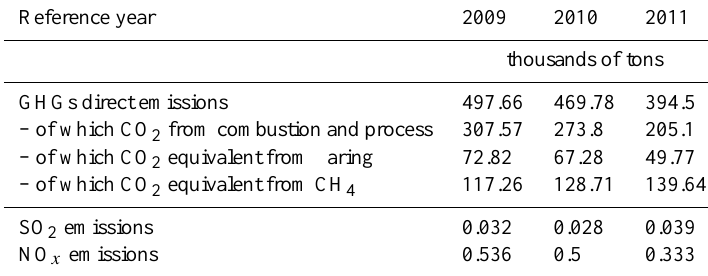
Table 7. Total yearly emissions from COVA (Source: ENI,